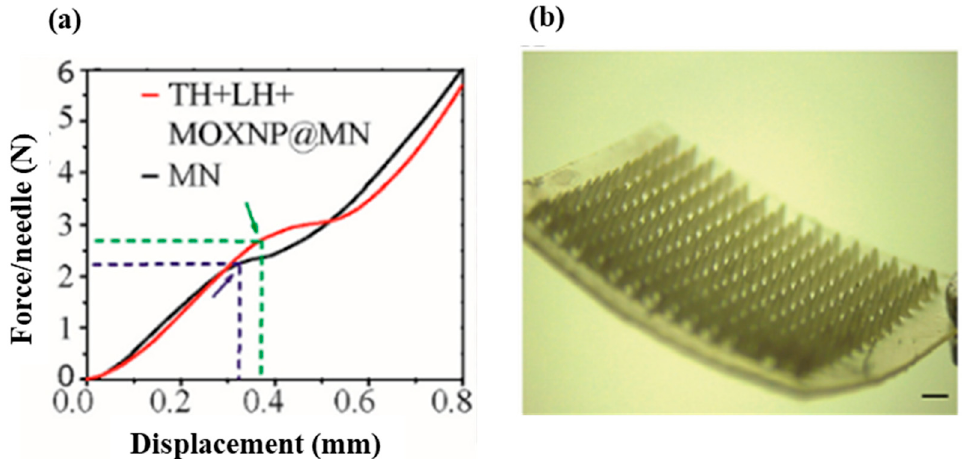
Figure 9. ( a ) Graph shows the mechanical strength of blank microneedle (MN) and Thrombin (TH) (LH) + Moxifloxacin nanoparticles (MOXNP@MN). ( b ) Visual presentation of pullulan-based mi- + Lidocaine(LH) + Moxifloxacin nanoparticles (MOXNP@MN) ( b ) Visual presentation of pullulan- croneedles (Magnification: 8 × , scale bar: 2 mm). Reproduced from [106], with permission from based microneedles (Magnification: 8×, scale bar: 2 mm). Reproduced from article [106], with per- mission from Elsevier, 2023. Elsevier,